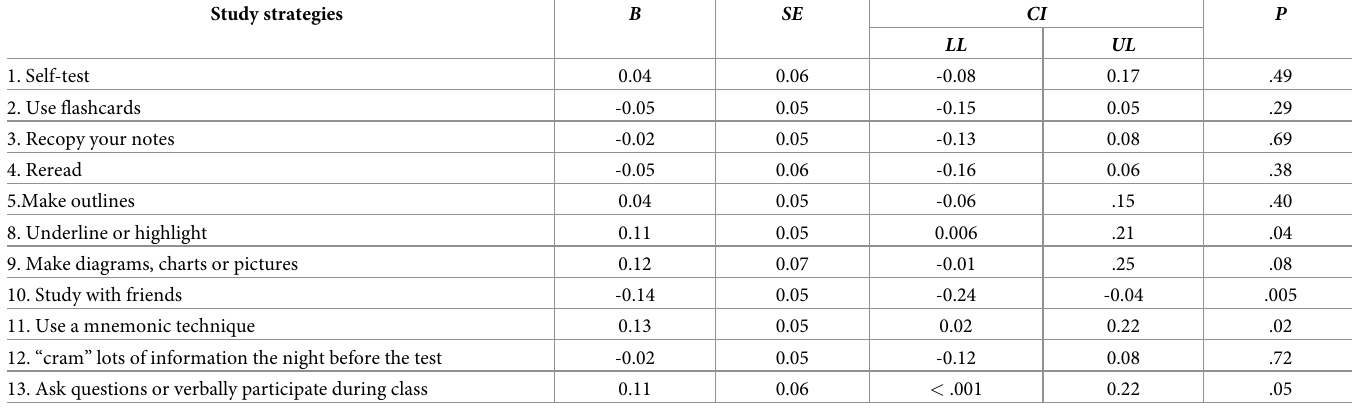
Table 2. Linear regression predicting GPA and from endorsement of specific study strategies. Study